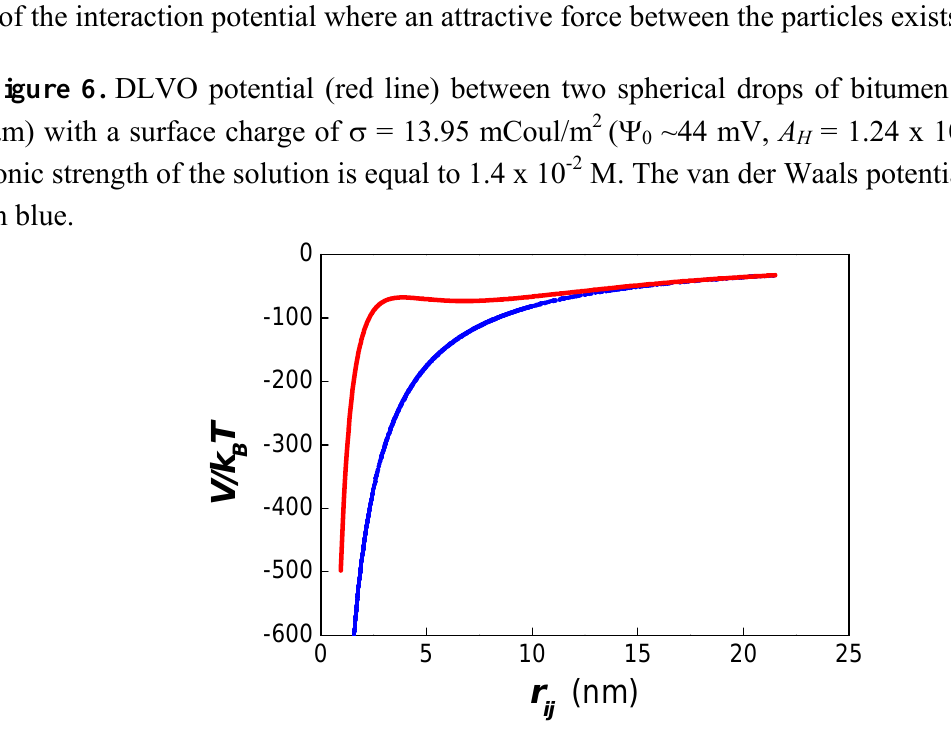
= 3.9 μ m) with a i ~44 mV, A = 1.24 x 10 -19 J). The ionic strength 0 H